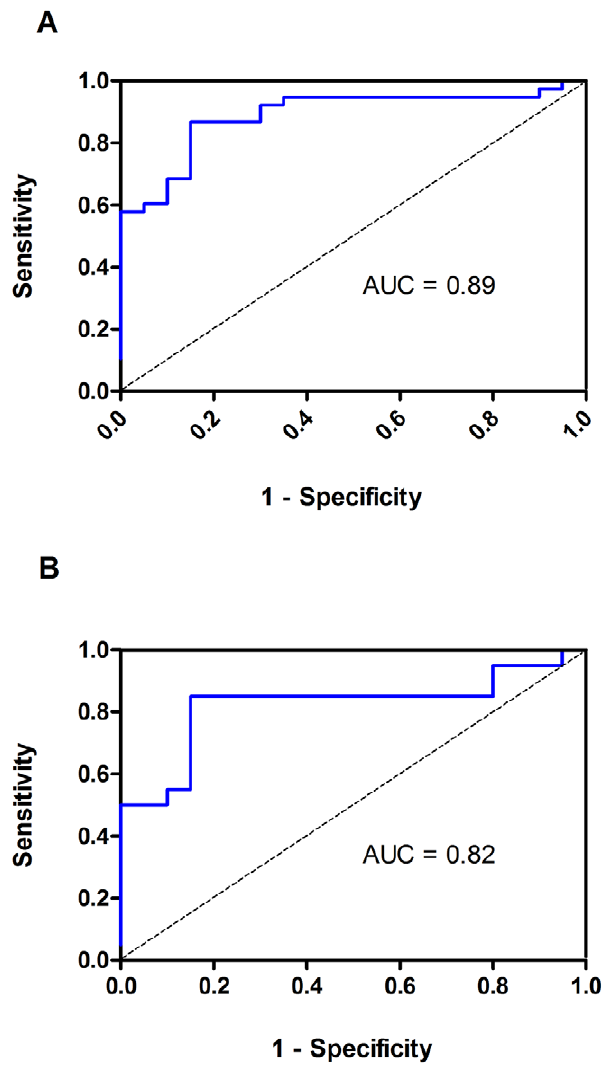
Figure 5. The receiver operating characteristics (ROC) curve for plasma methylated SLC19A3 DNA in the Phase II blinded validation (n=78). (A) Area under curve (AUC) value was 89%. At cutoff value of 0.41, sensitivity was 87% and specificity was 85% in discriminating 39 breast cancer patients from 20 control subjects. (B) Area under curve (AUC) value was 82%. At cutoff value of 0.41, sensitivity was 85% and specificity was 85% in discriminating 20 gastric cancer patients from 20 control